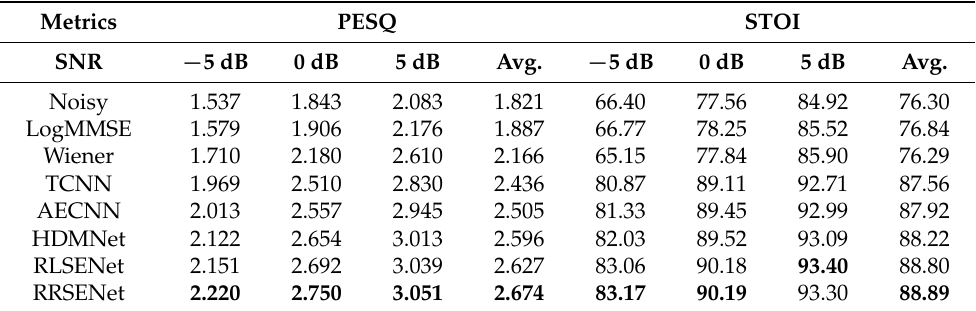
Table 1. Experimental results of different network models under seen noise conditions for PESQ and STOI. BOLD indicates the best result for each case.